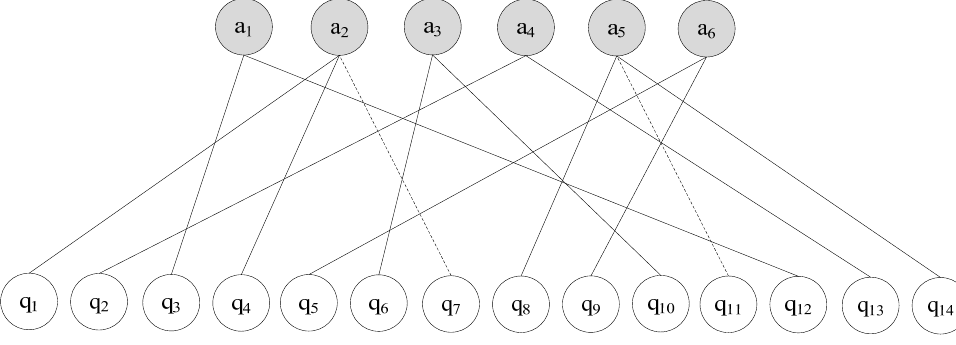
Figure 5. Graph model of the organizational structure of the project team (distribution option 8).